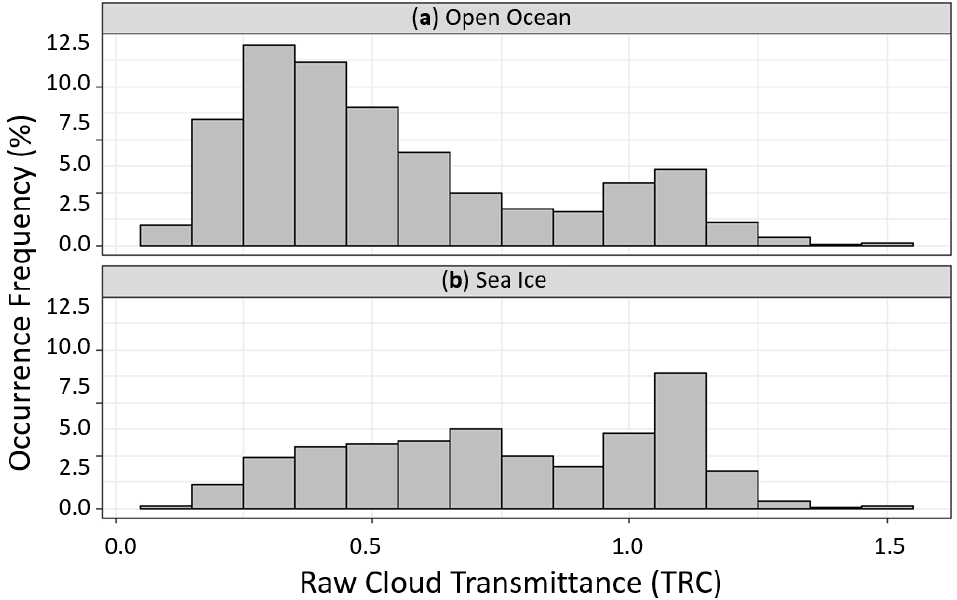
Figure 9. Frequency distribution of raw cloud transmittance (TRC) in percentage over ( a ) open ocean and ( b ) sea ice. Data are from all voyages.